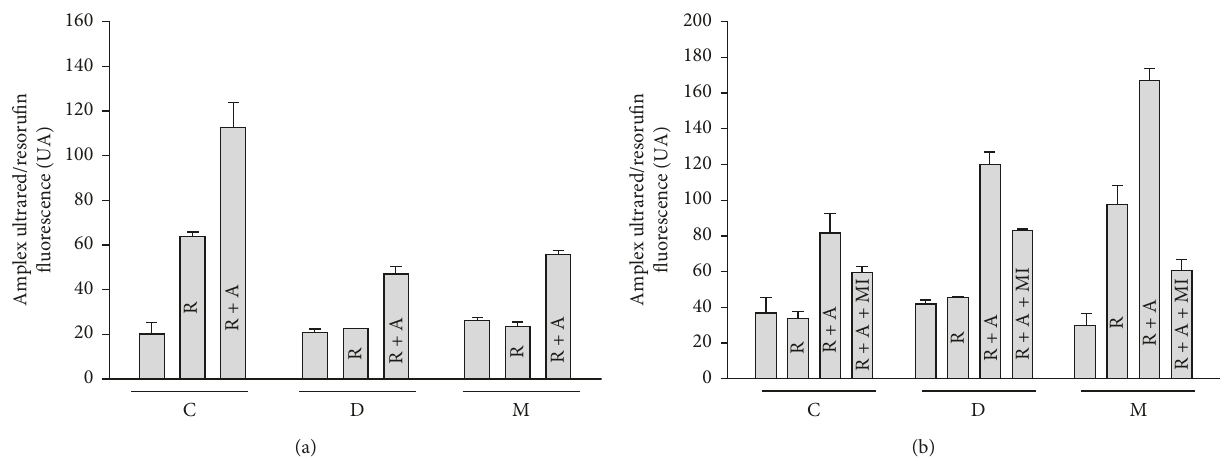
Figure 4: H 2 O 2 production by mitochondrial respiratory chain measured by Amplex Red (UA) in liver mitochondria from different treatments (C: control; D: diabetic; M: Moringa -treated diabetic groups) oxidizing (a) pyruvate plus malate or (b) succinate as substrates and the effects of respiratory chain inhibitors (R: rotenone; A: antimycin A; Ml: malonate). Mitochondria were studied during state 4 respiration. To correct for the increase in background fluorescence of the Amplex Red/HRP detection system overtime, fluorescence was monitored for a period of ten minutes. This background was subtracted from resorufin trace. Data are means